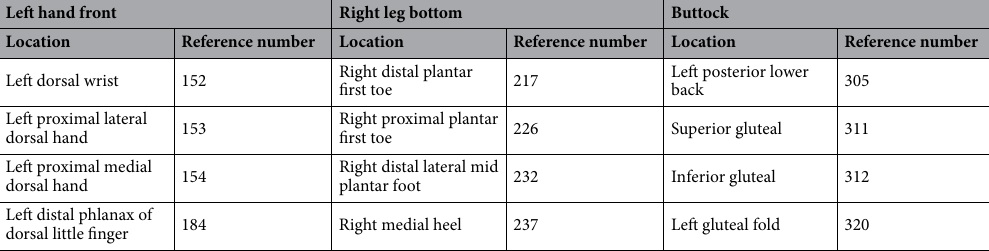
Table 1. Examples of locations and their corresponding mapping.